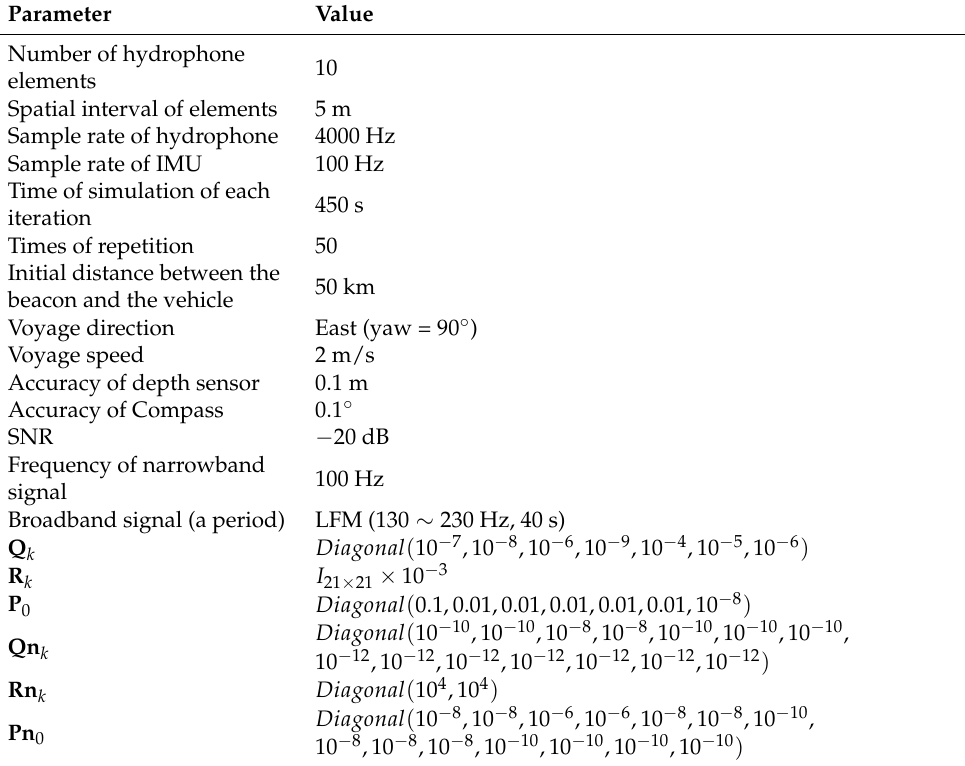
Table 5. Simulation configuration in motion restriction